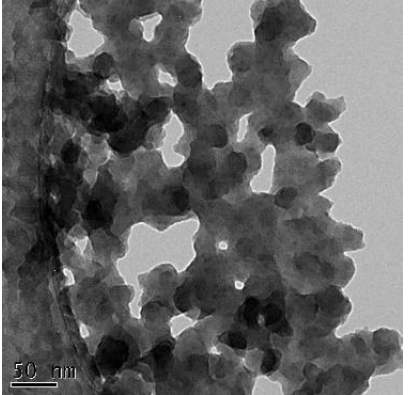
Figure 4. TEM image of silica nanoparticles embedded in the polyamide layer.